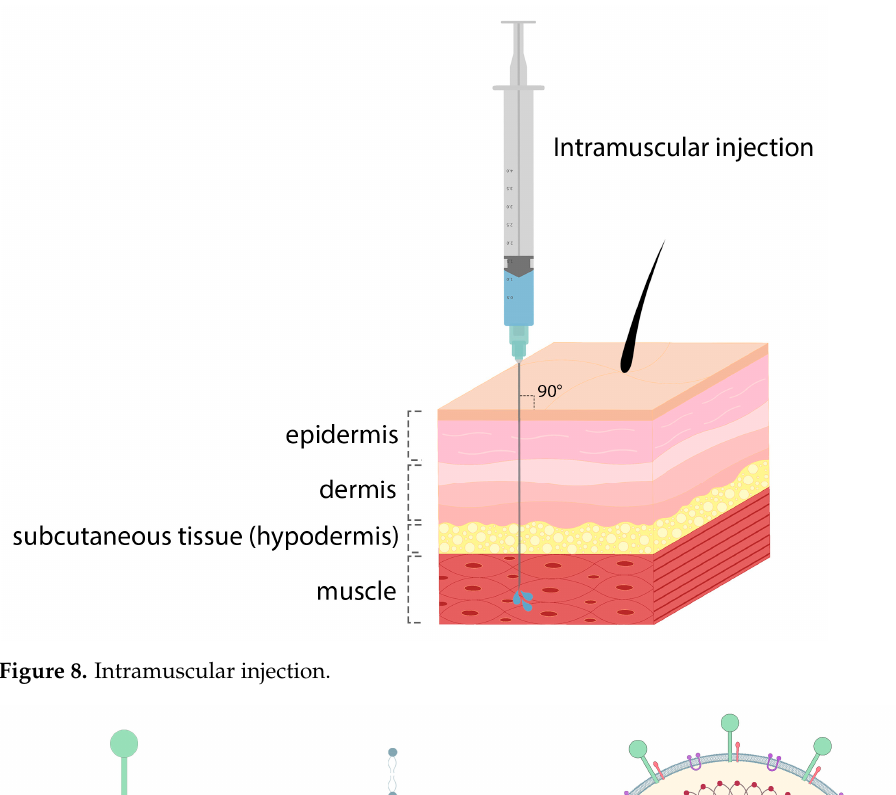
Figure 8. Intramuscular injection.